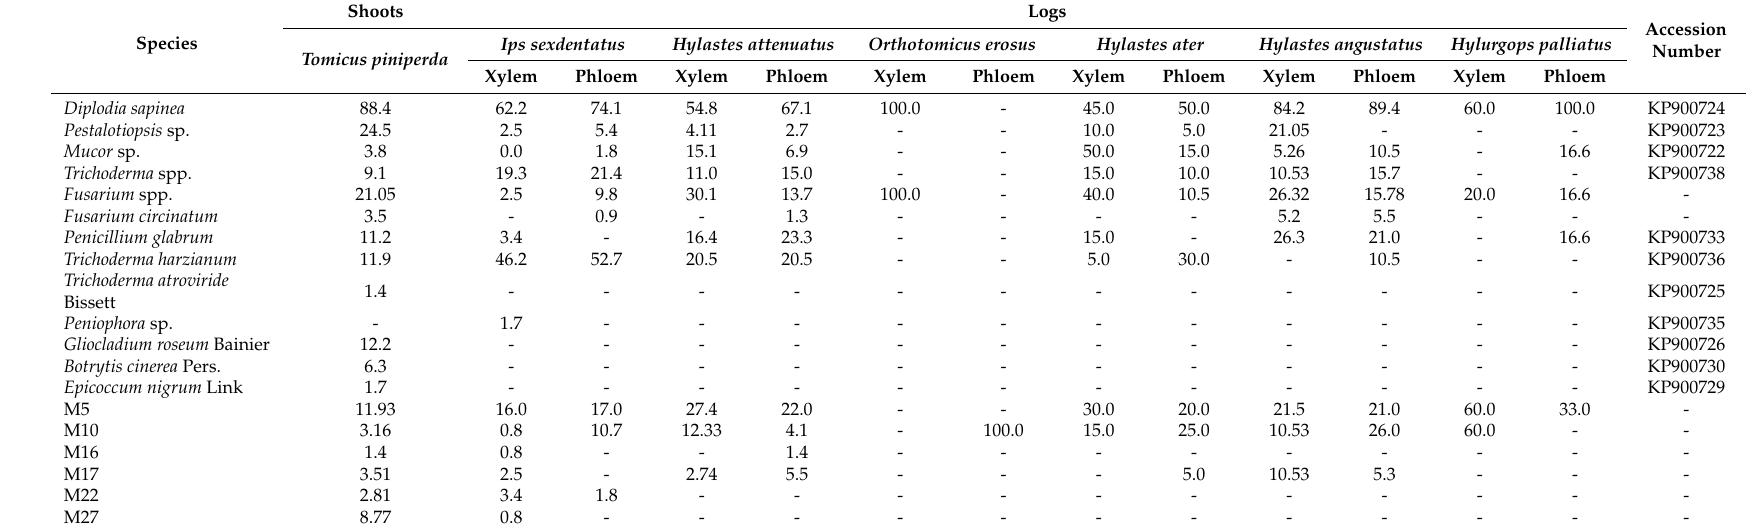
Table 2. Percentage of plant tissue samples containing each fungal